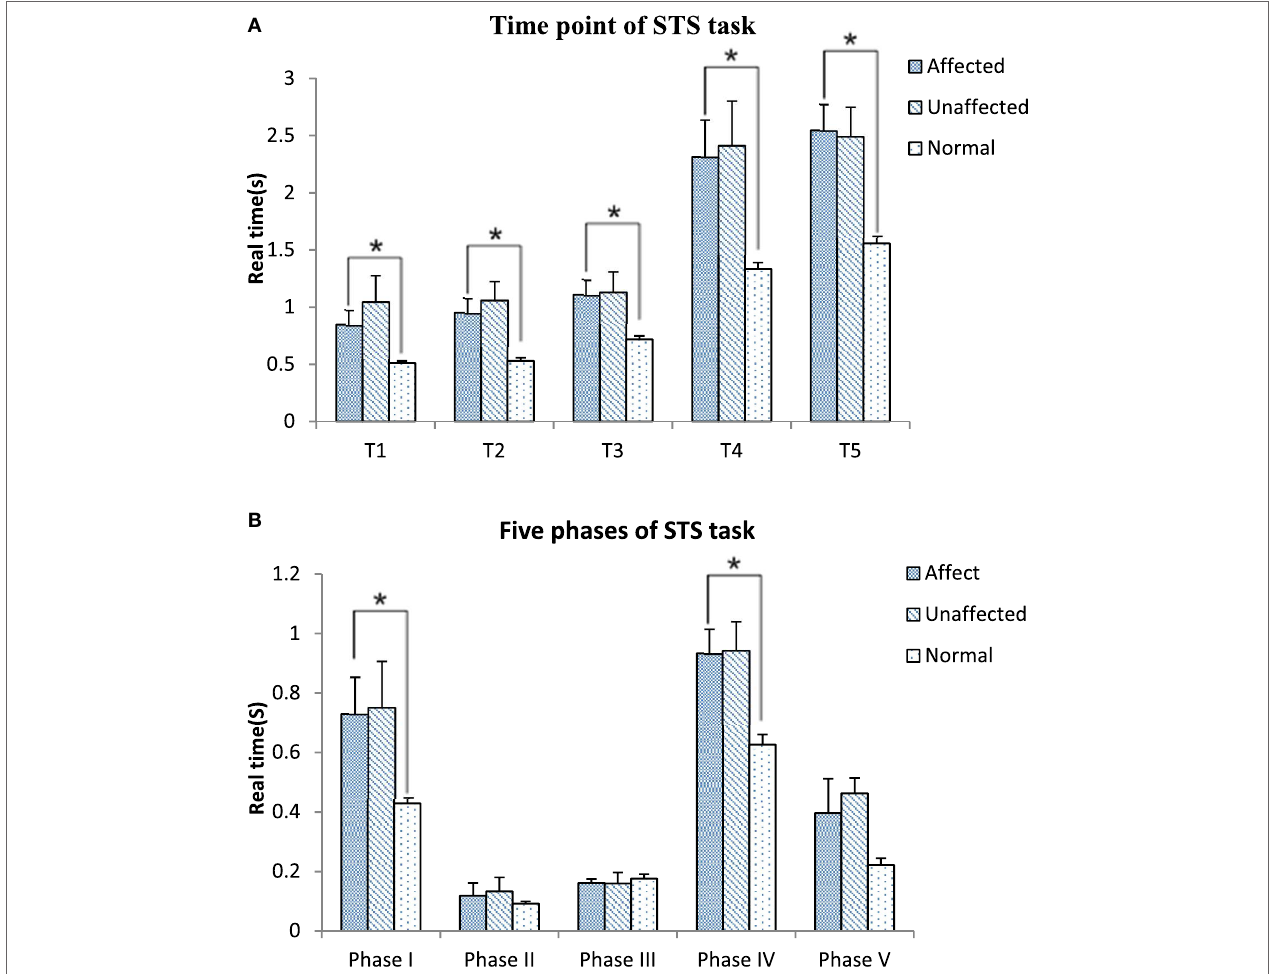
FigUre 3 | Time point (a) and five phases (b) comparisons among the affected, unaffected side of stroke and healthy controls during sit-to-stand (STS) task (* p <